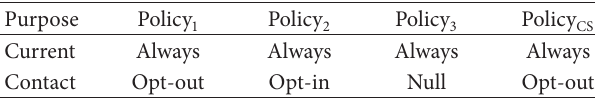
Table 9: Required values of Purpose values in TravelBroker.